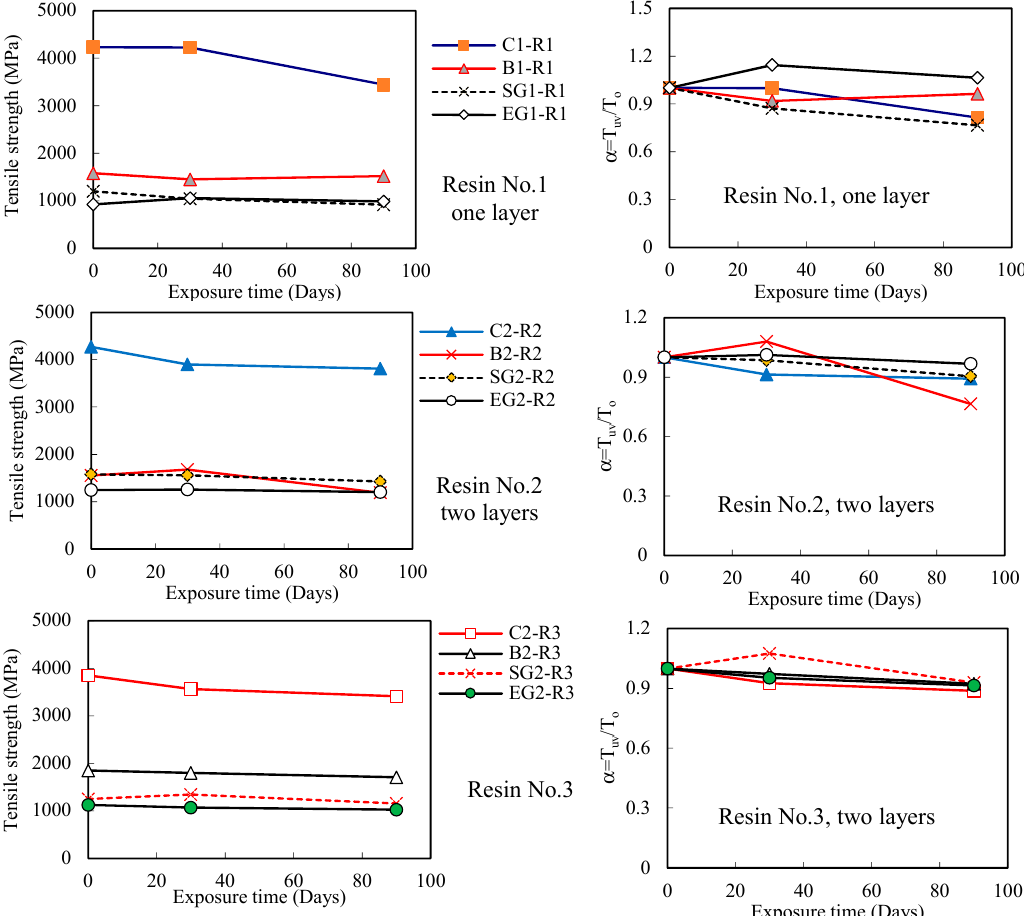
Figure 8. Effect of UV exposure on the tensile strength of different FRPs.